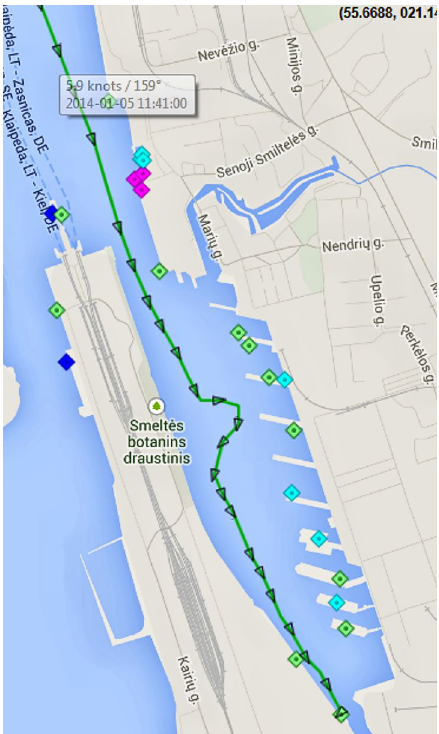
Fig. 8. A track of the real ship ( L = 180 m) sailing to Malkų Bay (received by AIS devices)